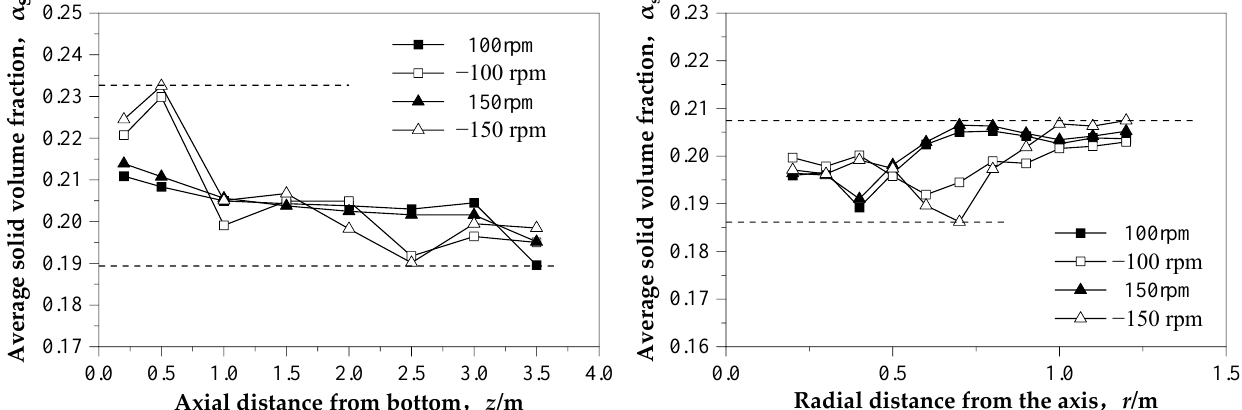
Figure 5. The solid volume frame in different positions.